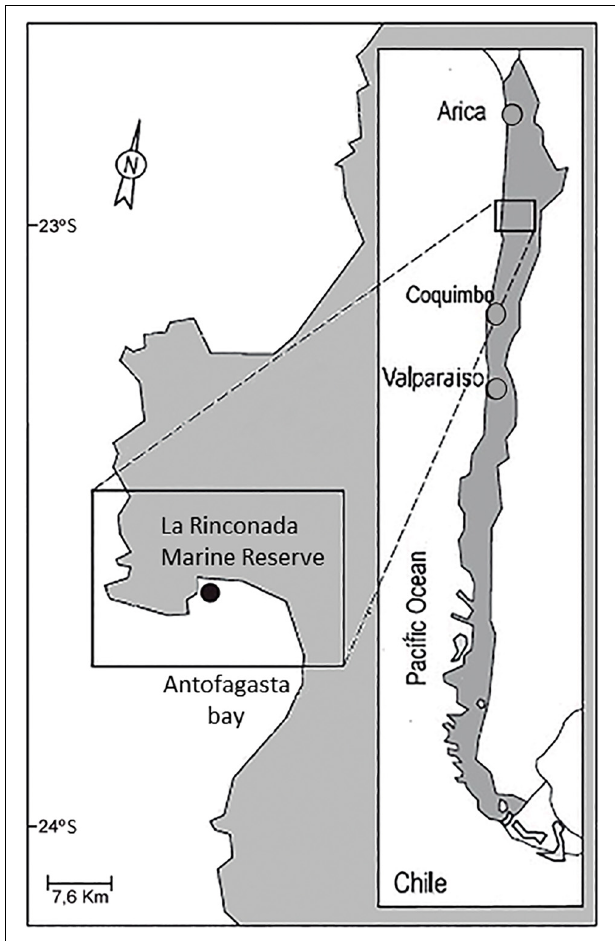
FIGURE 1 | Map of the Antofagasta Bay (northern Chile) and the sampling station (black dot) in La Rinconada Marine Reserve.